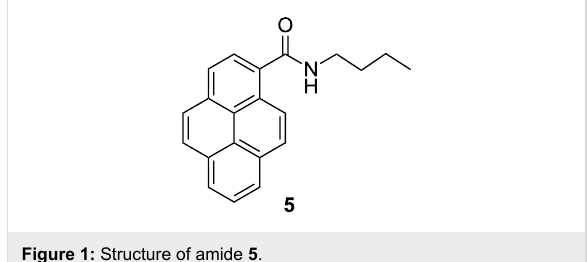
Figure 1: Structure of amide 5